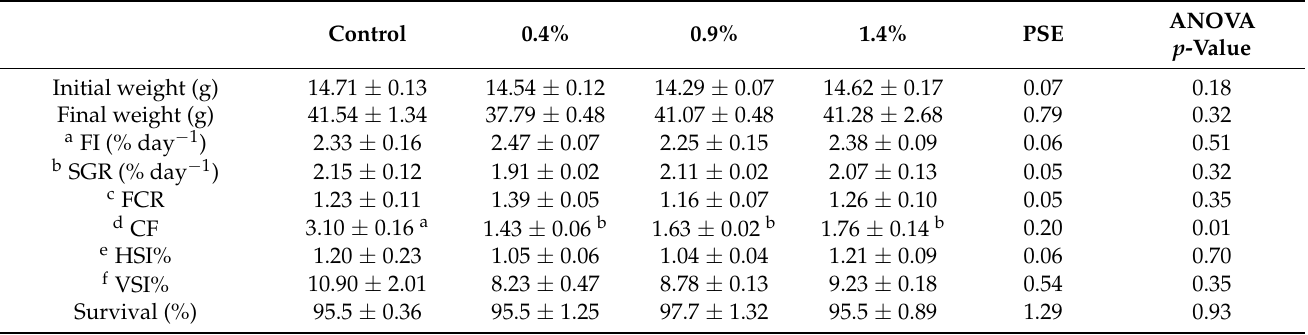
Table 4. Growth performance of S. dorsalis fed diets containing different levels of